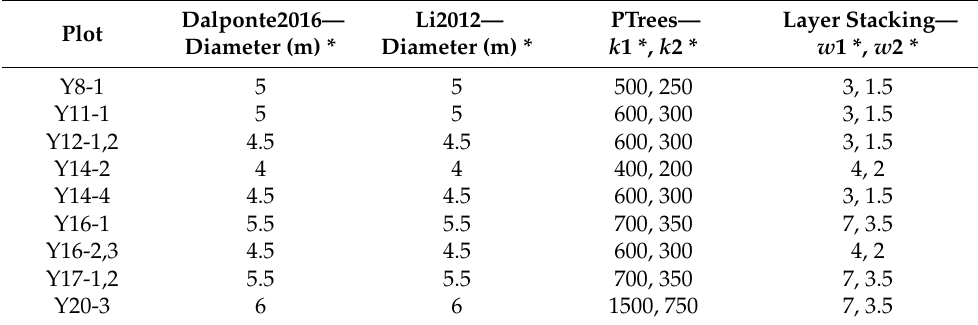
Table 3. Parameters of four segmentation methods among plots in the leaf-on season.